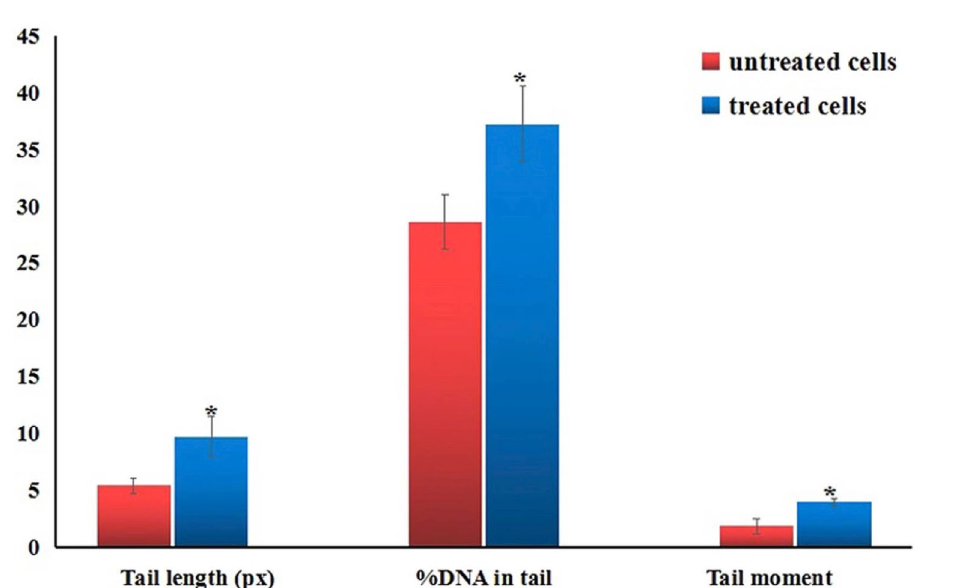
Figure 5. Tail length, %DNA in tail and tail moment in the control and treated Hep-G2 cells with IC50/72 h (6.21 µg/ml) of Erbium Oxide nanoparticles. Results are expressed as mean ± SD. *Indicates statistical significant difference from the compared control at p < 0.05 using student